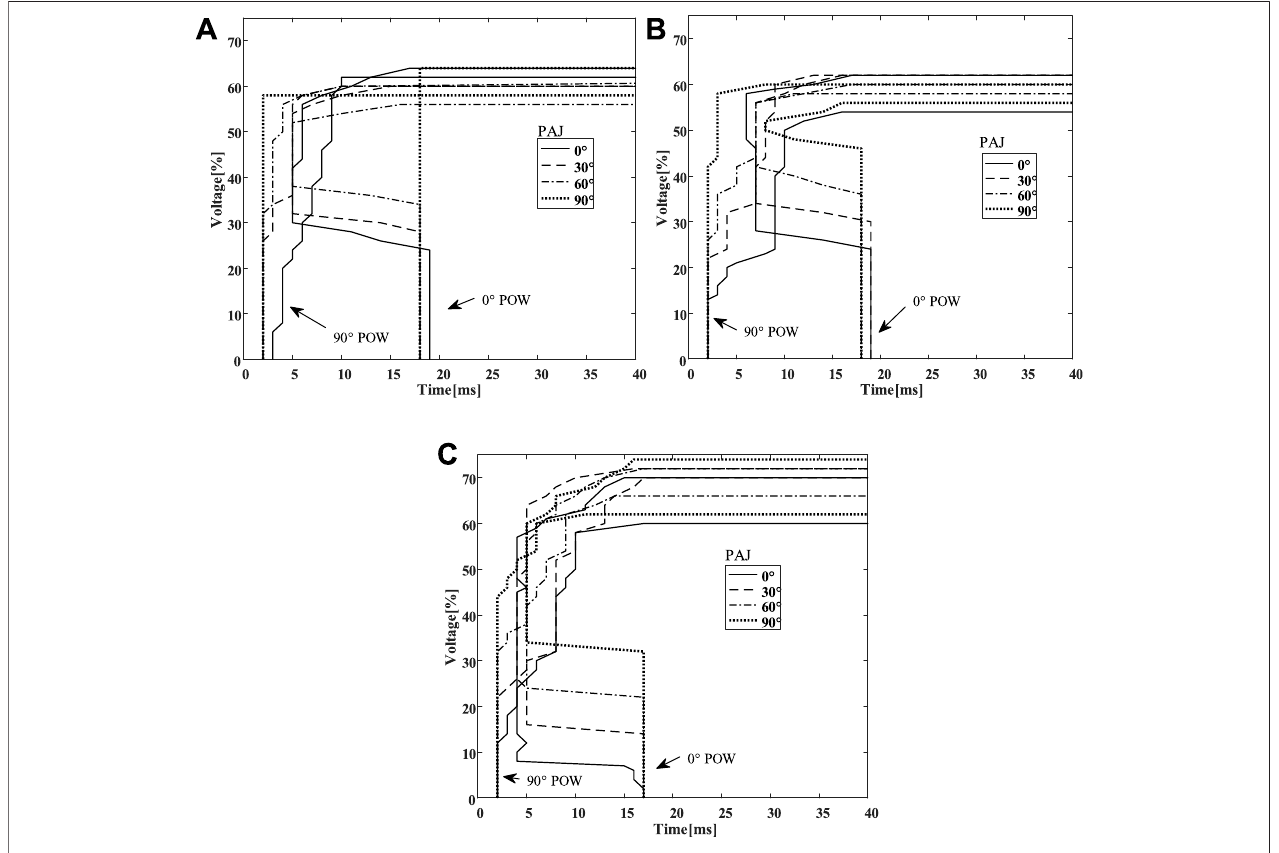
FIGURE 10 | Test results considering the different PAJ (0 ° POW and 90 ° POW). (A) Results for R2. (B) Results for R5. (C) Results for R8.